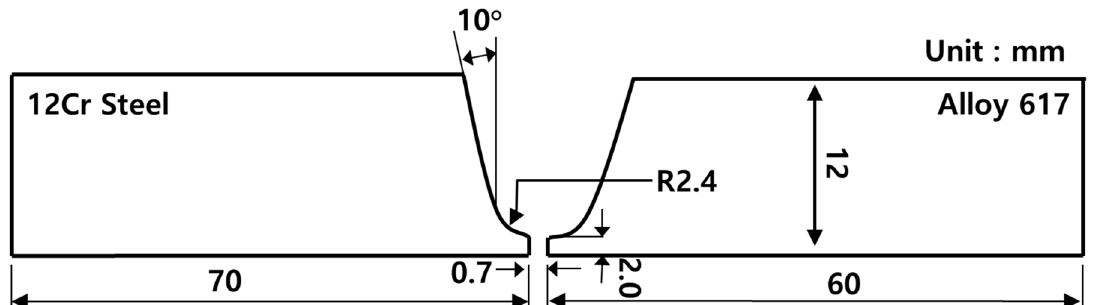
Figure 1. Specimen with U-groove for dissimilar material welding.